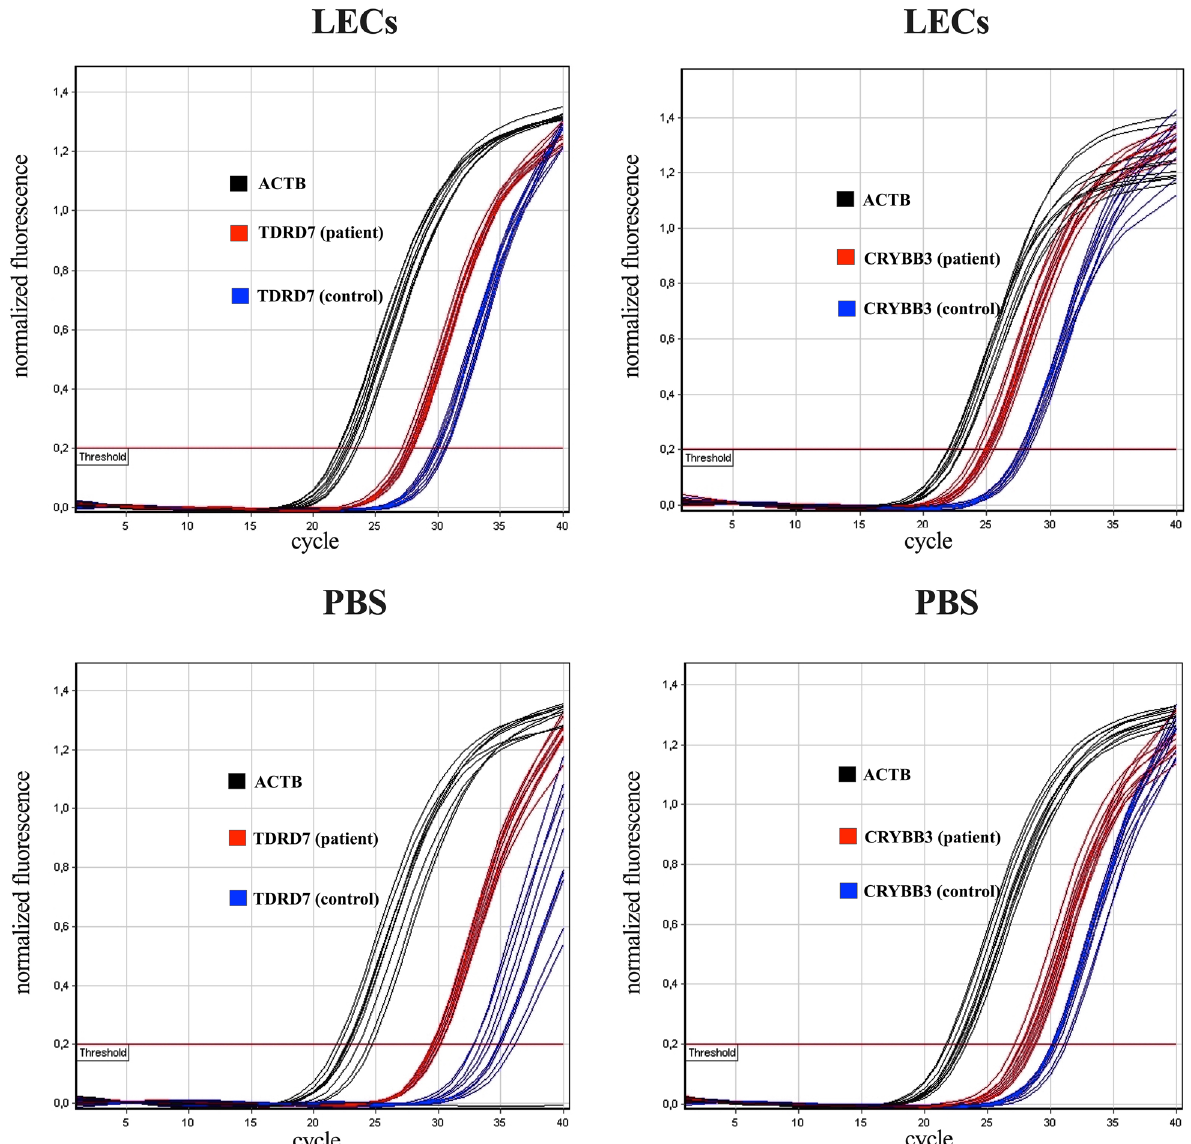
Fig. 1 Comparison of expression levels of TDRD7 and CRYBB3 in patient groups versus control groups by quantitative real-time